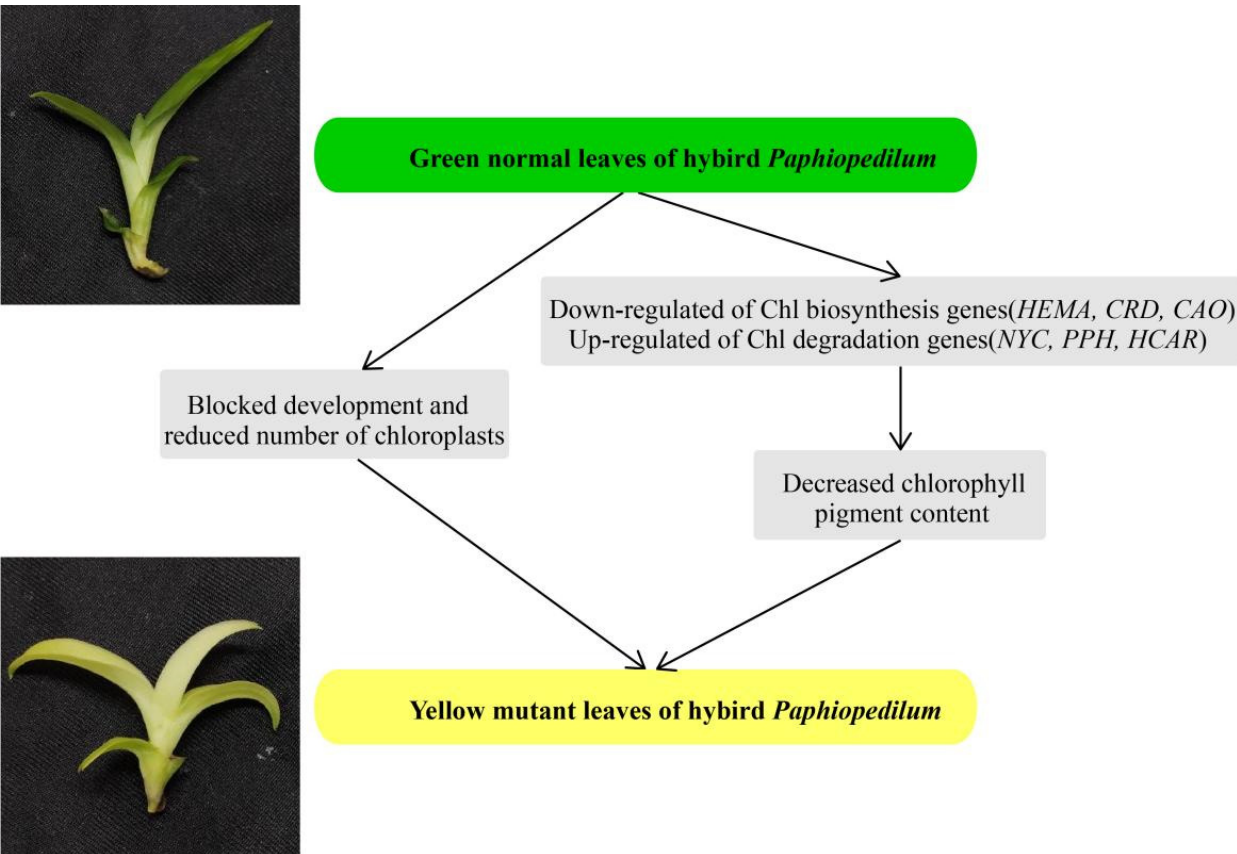
Figure 10. A proposed model for the mutant leaf coloration in the Paphiopedilum hybrid.